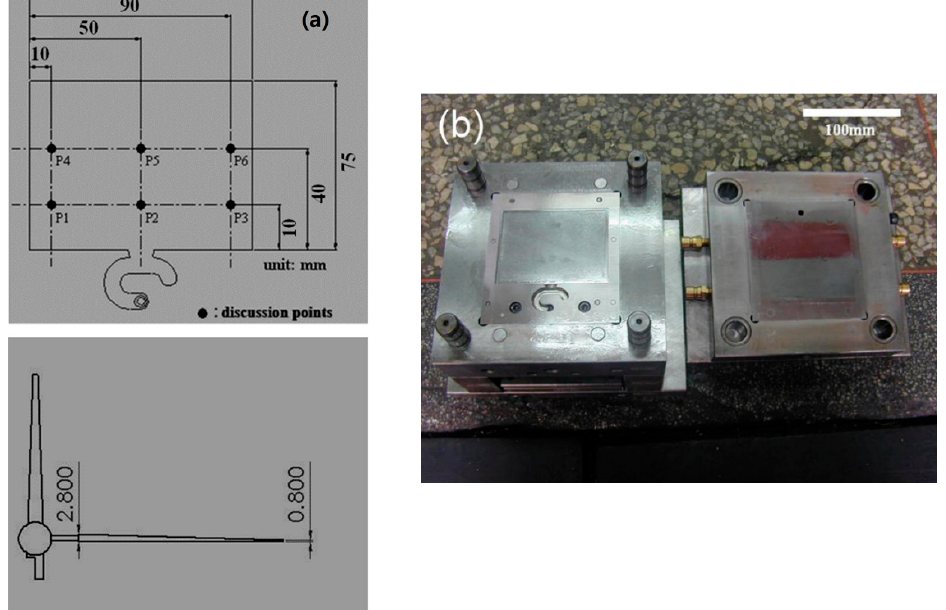
Figure 1. Layout and dimensions on mold. ( a ) Mold cavity and locations of discussion points. ( b ) Mold.